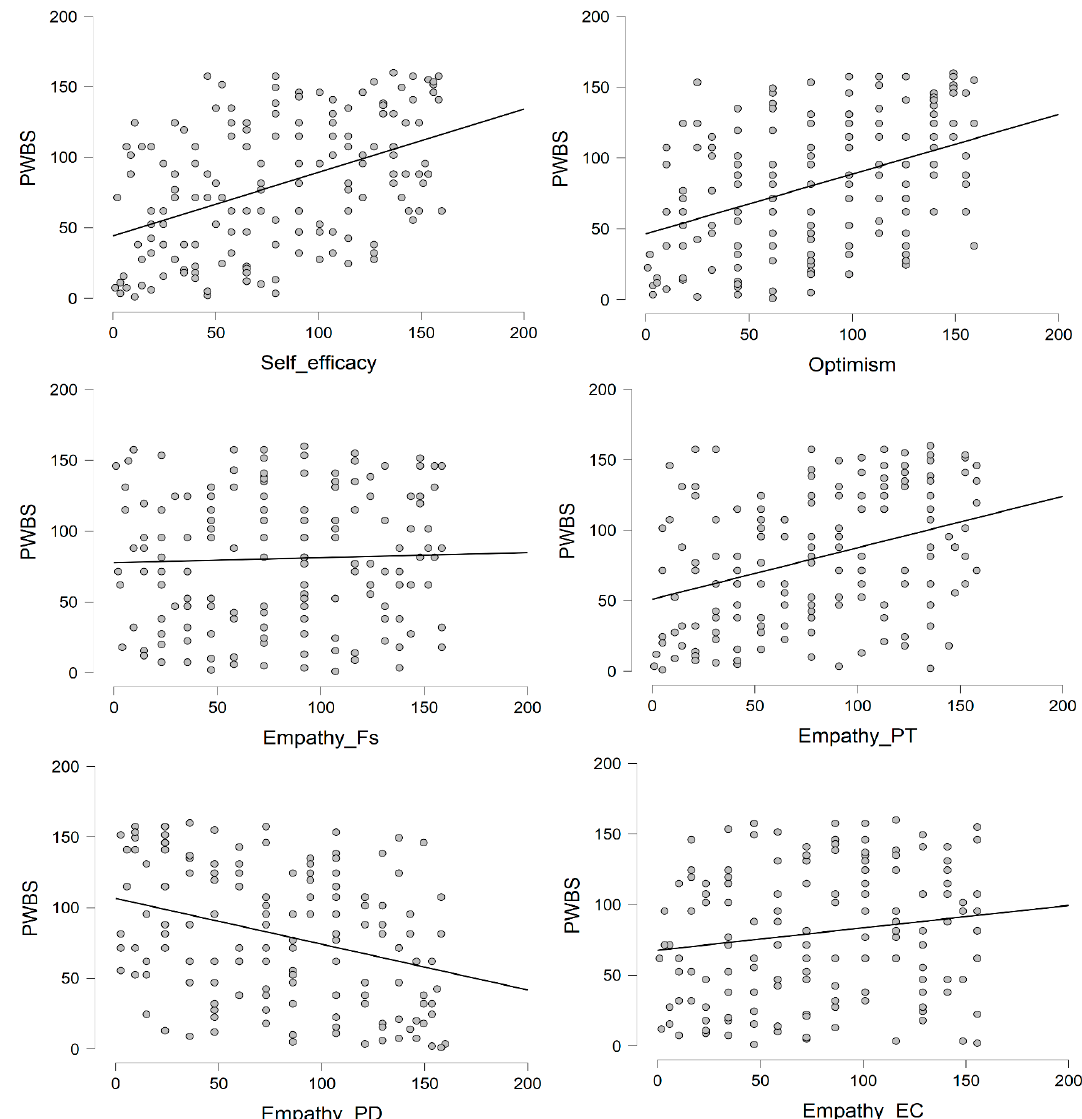
Figure 1. Scatterplots of correlations of psychological well-being with other psychological variables. PWBS = Psychological well-being; Fs = Fantasy; PT = Perspective Taking; PD = Personal Distress; EC = Empathic Concern.